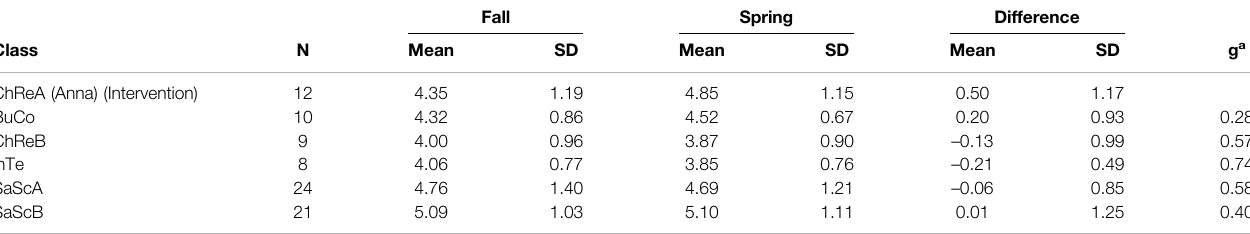
TABLE 4 | Controlled motivation in the intervention and comparison classes in the fall and spring and their difference. Fall Spring Difference Class N Mean SD